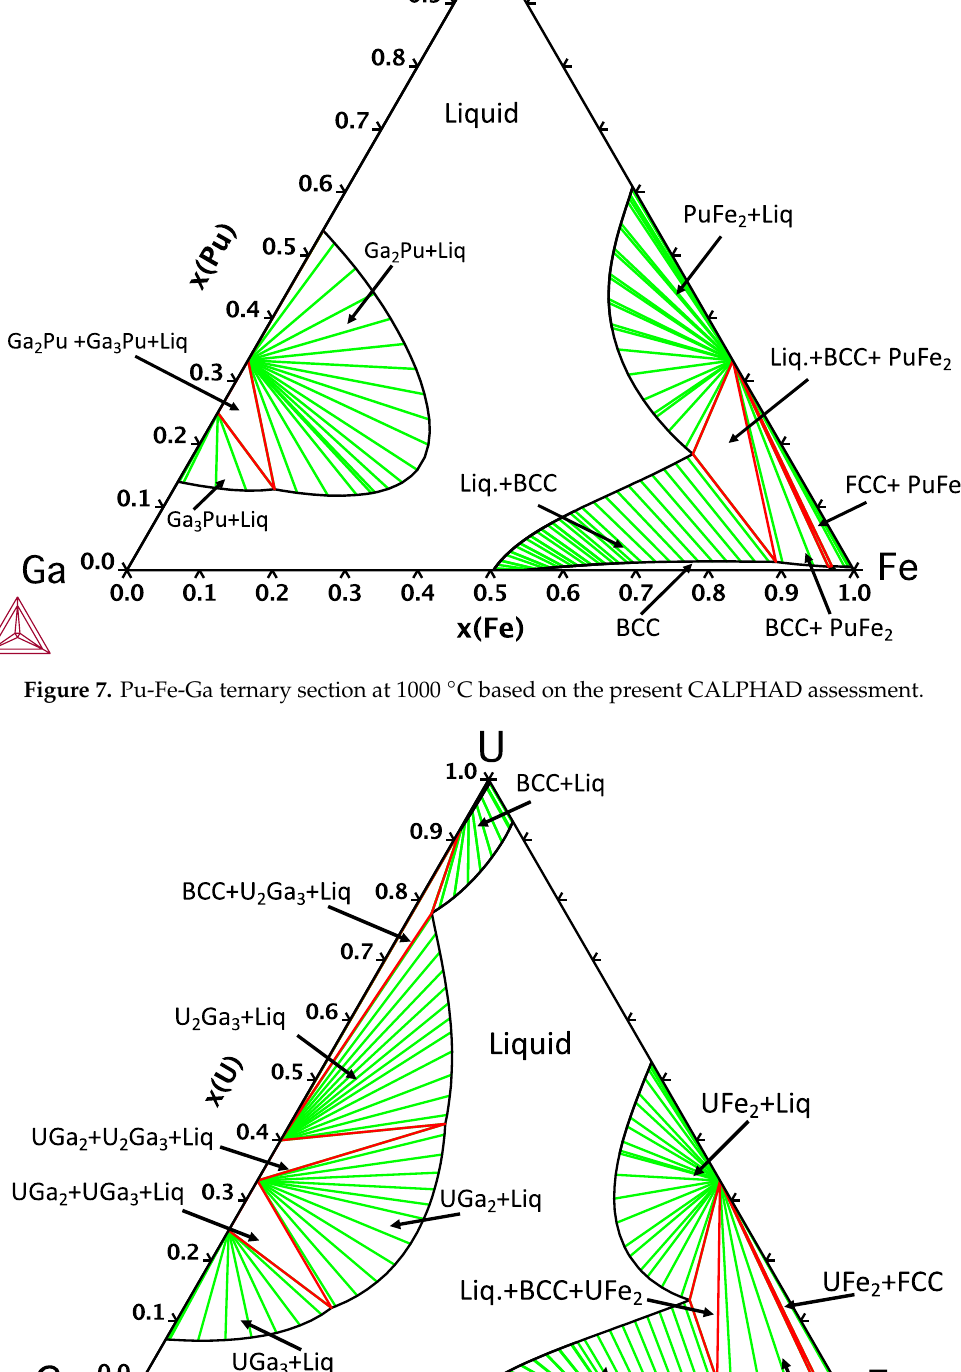
Figure 8. Calculated U-Fe-Ga ternary section at 1000 °C based on the present CALPHAD assessment.